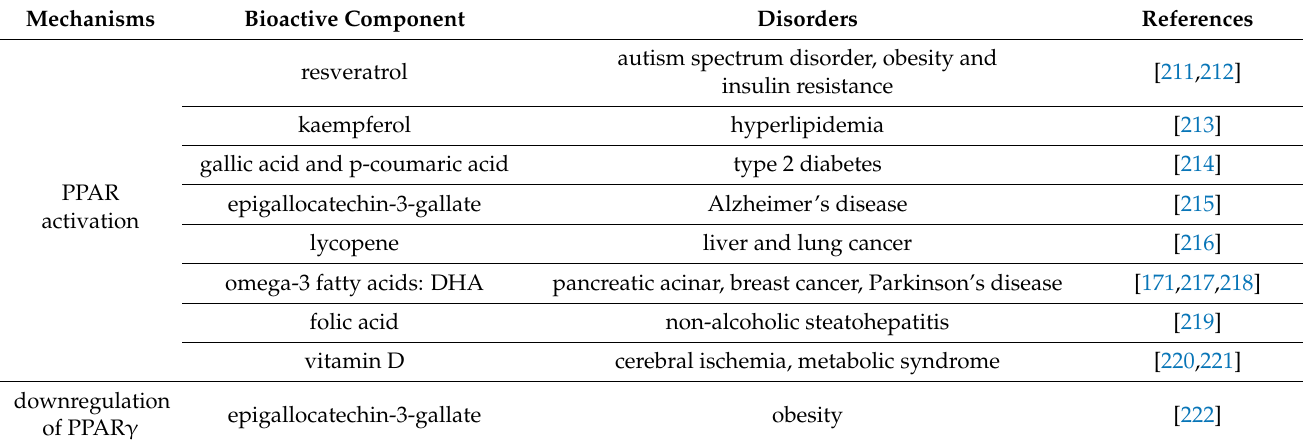
Table 4. Bioactive components of the diet and their role in transcription factor activity